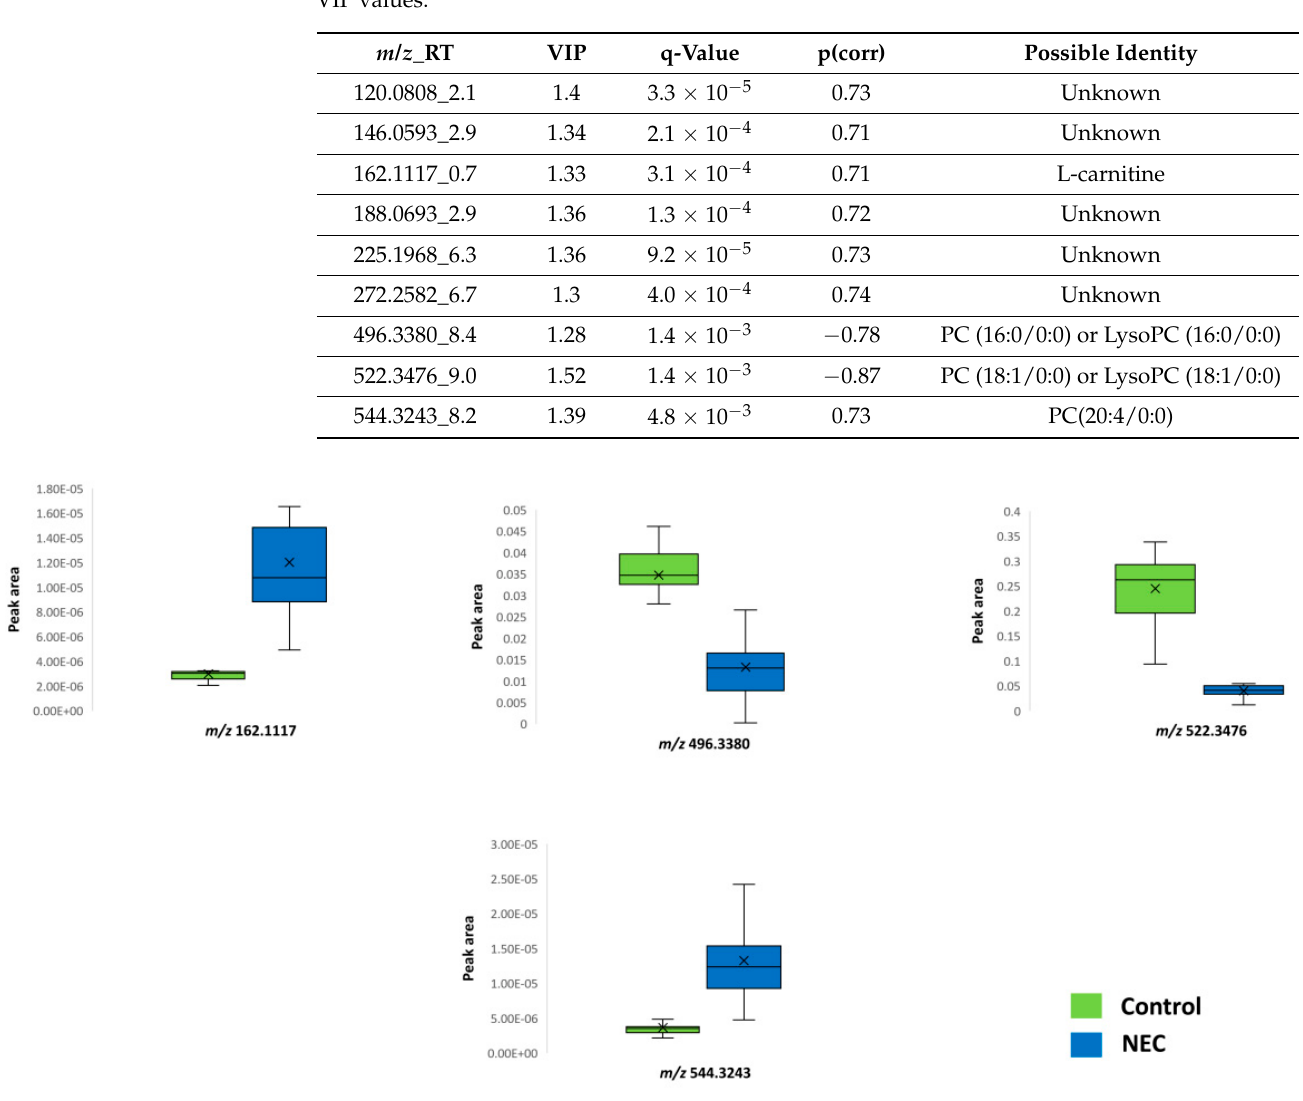
Table 2. Statistically significant features with their respective q-value (Bonferroni), p(corr), and VIP values.